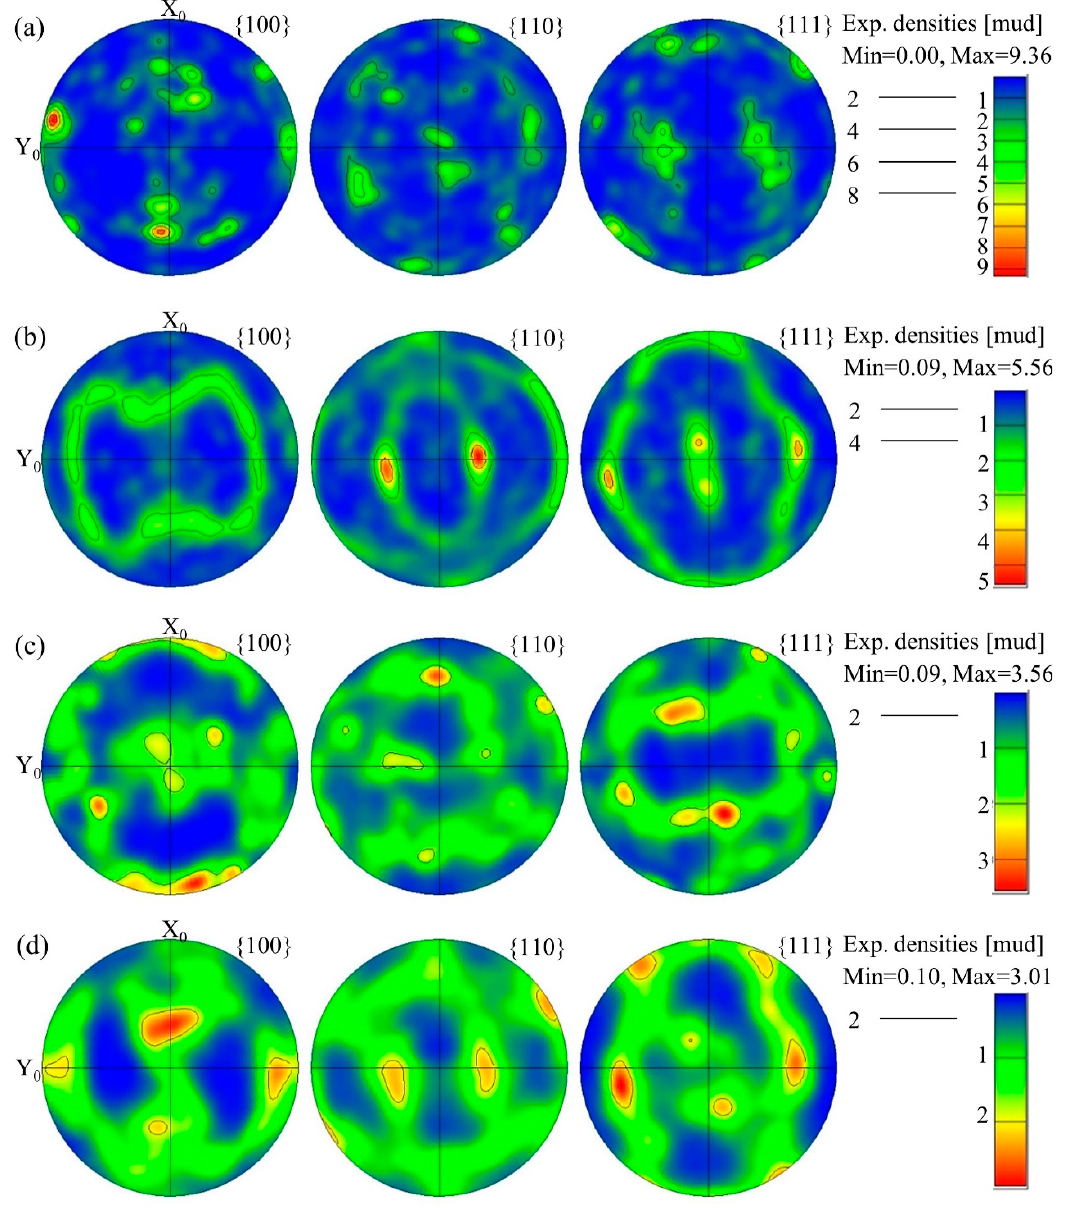
Figure 7. {100}, {110}, and {111} pole fi gures of the 2A14 Al alloy: ( a ) hot-rolled state after annealing to ( b ) 505 °C, ( c ) 555 °C, and ( d ) 580 °C. to ( b ) 505 ◦ C, ( c ) 555 ◦ C, and ( d ) 580 ◦